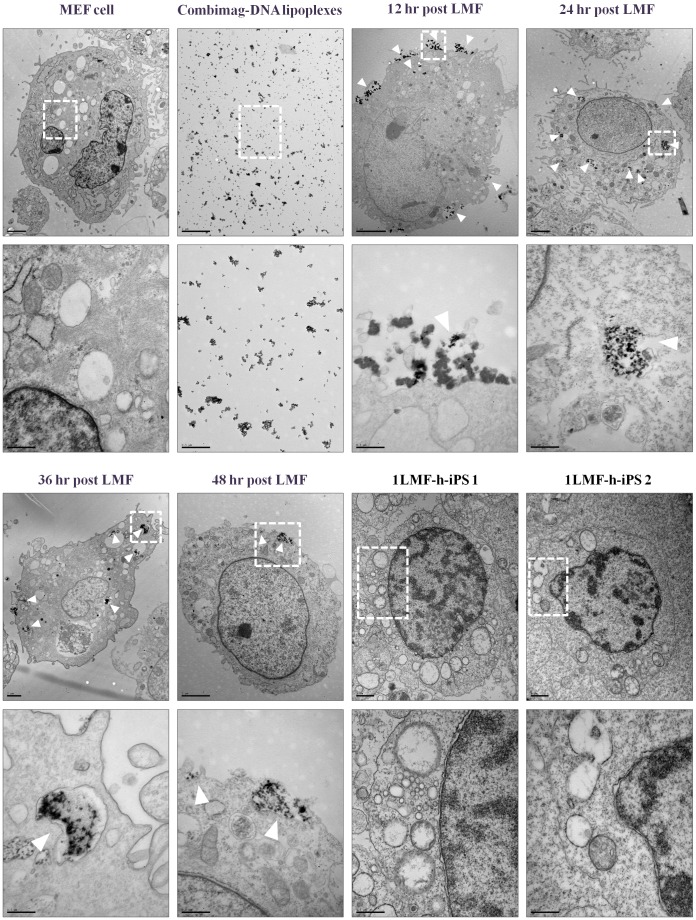
Transmission electron microscopic analysis of MEFs, CombiMag-DNA lipoplexes, LMF-treated MEF cells at 12 hr intervals until 48 hrs, and two LMF-iPS cell lines.The lower photos represent magnifications of the white-dotted square in each upper photo, and the white arrowheads indicate the presence of liposomal magnetofection particles in LMF-MEF cells. Upper: low magnification, x6,000–8,000; lower: high magnification, x50,000.